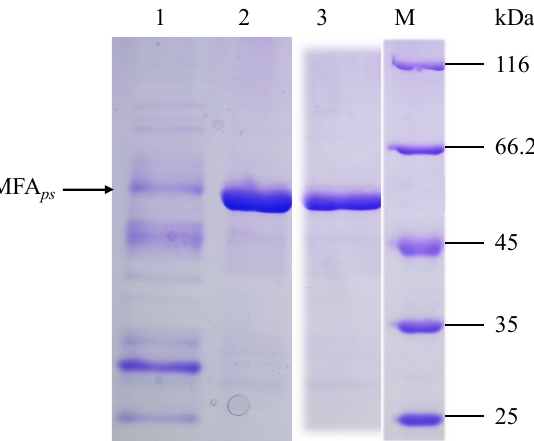
Figure 3. The SDS-PAGEs of culture fluids containing the recombinant forms MFA ps and purified enzymes. Lane M is marker (kDa); lane 1 is wild-type recombinant strain; lane 2 is the purified variant A211C-S214C; lane 3 is the purified variant S409C-Q412C. Black arrows indicate the band of 53 kDa. Table 2. Activities and kinetic parameters for mutants compared to wild-type MFA ps on maltodex- trin (DE = 4) at 50 °C.